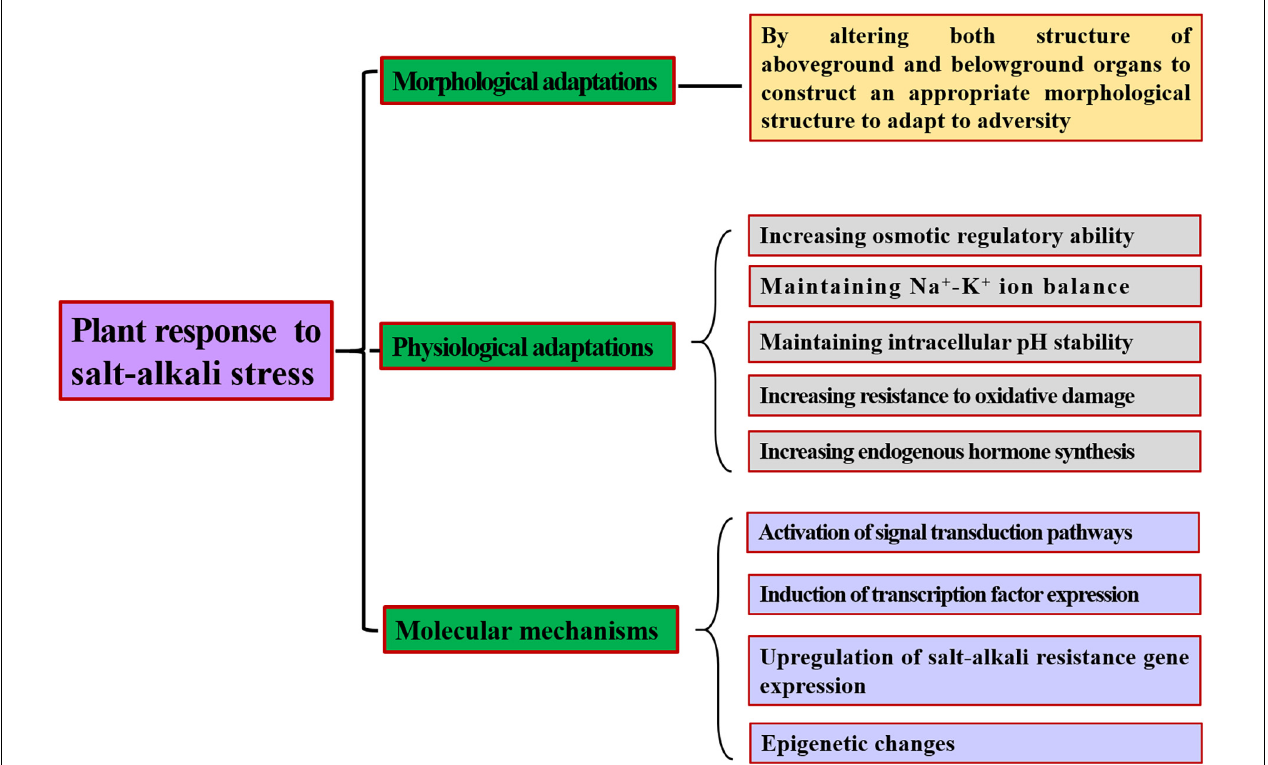
FIGURE 2 | The response mechanism of plants to saline-alkali